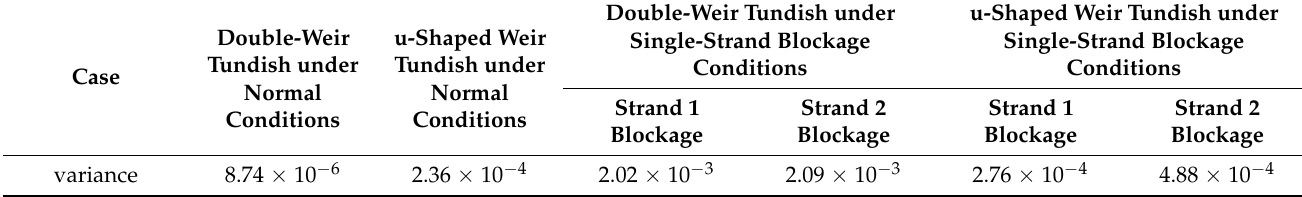
Table 3. Time average variance of outflow percentage of each strand under normal condition and single-strand blockage condition of two designs of